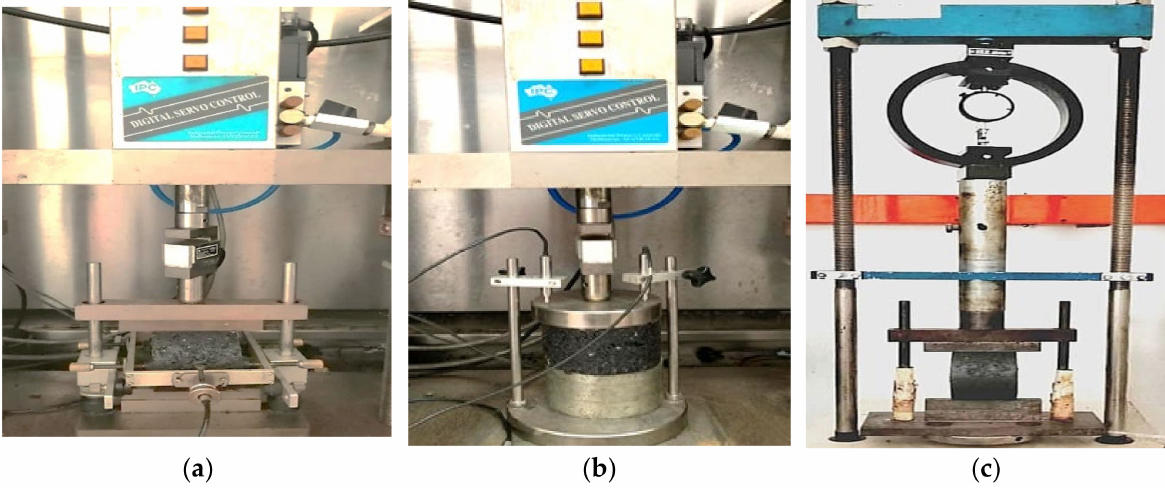
Figure 2. Laboratory tests: ( a ) stiffness modulus ( b ) dynamic creep; ( c ) Indirect tensile